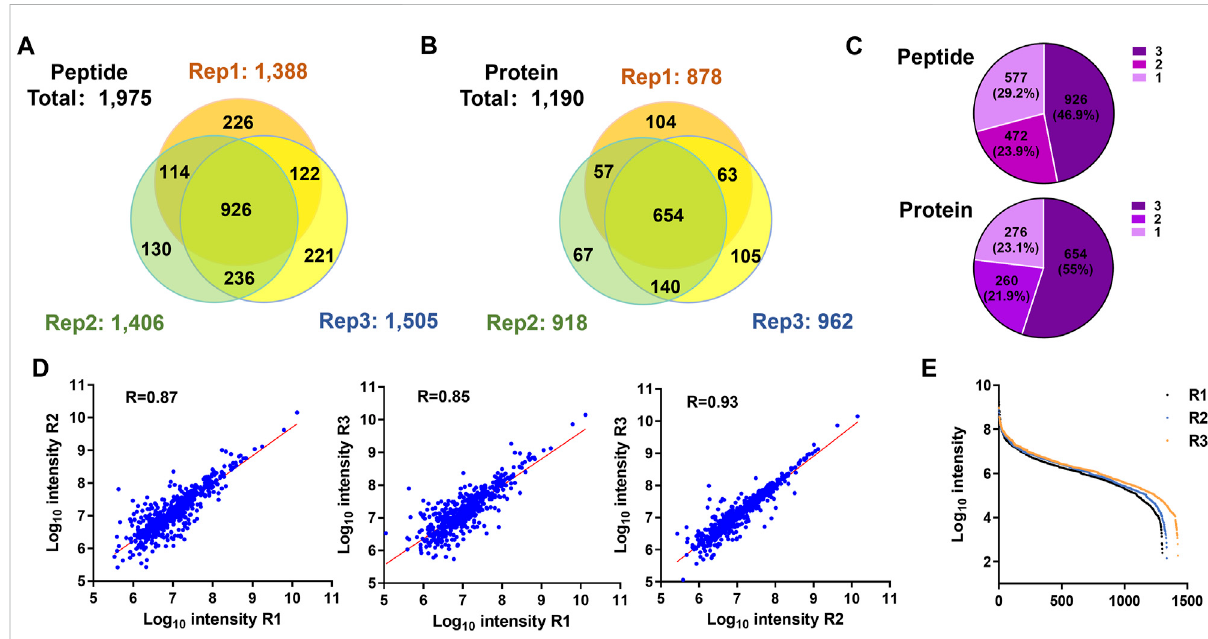
FIGURE 4 Highly ef fi cient and high-throughput identi fi cation of protein C termini from 293T cells by using the PBC strategy. (A,B) Overlap analysis of C-terminal peptides (A) and proteins (B) from the triplicate experiment of C-terminal peptide enriched by using the PBC strategy. (C) Pie chart analysisofthefrequencyofC-terminalpeptidesidenti fi cationfromtechnicaltriplicates.Atotalof46.9%peptides(926peptides)wereidenti fi edinall the triplicates, and 70.8% peptides (1,398 peptides) were identi fi ed in at least two replicates. (D) Correlation of intensity analysis of identi fi ed C-terminal peptides among technical triplicates. (E) Peptide abundance dynamic range of technical triplicates through the PBC strategy. The abundance dynamic range was larger than seven orders of